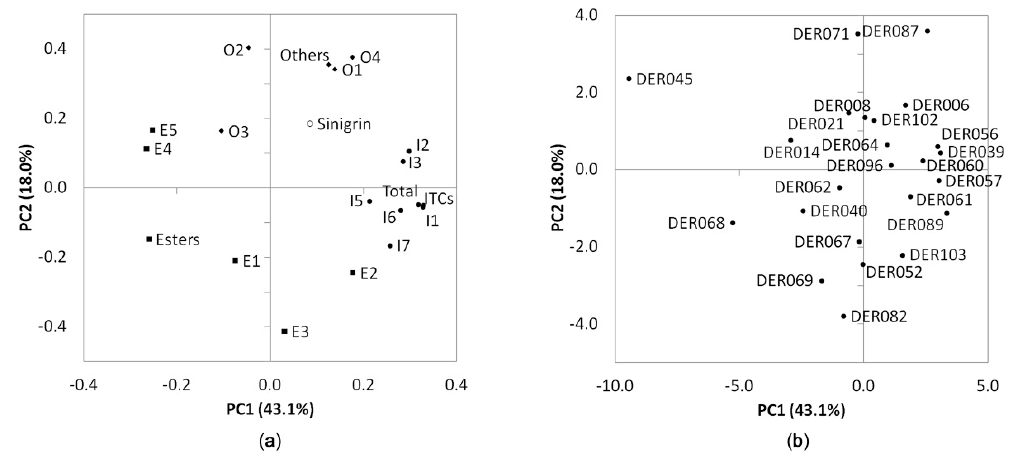
Figure 2. Principal Component Analysis of the 24 populations of wall rocket evaluated in the study, in the first (PC1) and second (PC2) components. ( a ) PCA loading plot for the volatile organic compounds and content in sinigrin. ( b ) PCA score plot for the populations. Data were averaged for each accession. For compound identities refer to Table 3.